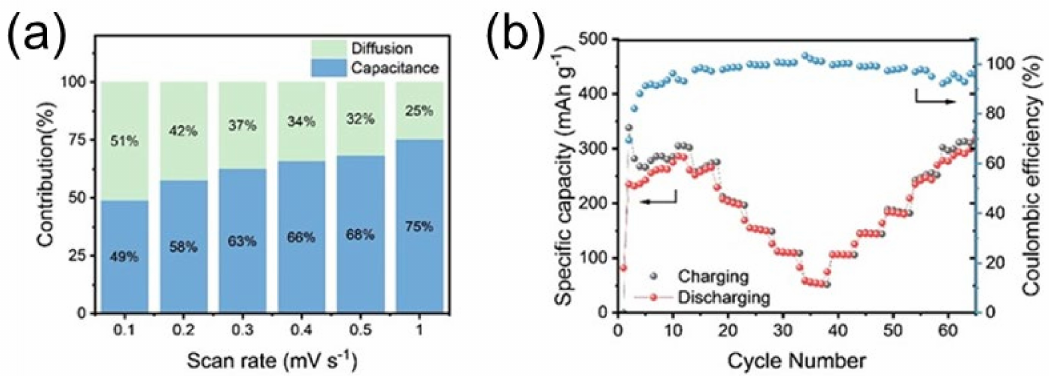
Figure 12. SAPAM electrolyte under the full-cell test: ( a ) diffusion-capacitive control contribution is presented in the bar chart, and ( b ) charge/discharge rate performance of current densities from 0.1 to 5 Ag − 1 . Reprinted with permission from Ref. [80]. Copyright 2021 American Chemical